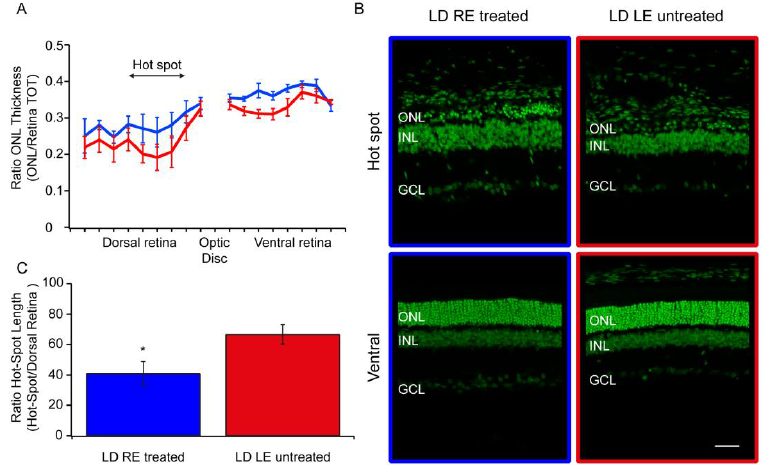
Figure 2. CBS treatment preserves retinal morphology. ( A ) The graph shows retinal outer nuclear layer (ONL) thickness measured in treated (LD RE treated, blue) and untreated (LD LE untreated, red) animals both in the dorsal and ventral region. ONL thickness is expressed as a ratio of ONL thickness to the retinal thickness to compensate for possible oblique sectioning. ( B ) Treated (LD RE treated, blue frame) and untreated (LD LE untreated, red frame) retinas stained with Hoechst to visualize the retinal nuclear structure in the hot-spot and ventral area, respectively. Scale bar: 50 µm. ( C ) Hot-spot lateral extension measured as the ratio of hot-spot length to dorsal retina length: treated (LD RE treated, blue) and untreated (LD LE untreated, red). * p < 0.05. Biomolecules 2020 , 10 , x FOR PEER REVIEW